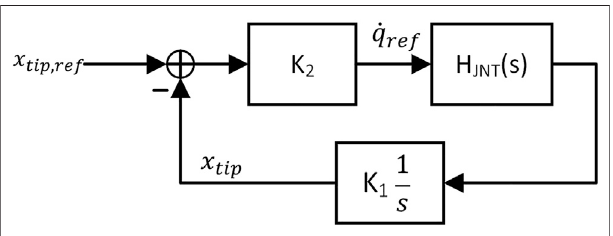
FIGURE 8 | Vision-based servo loop expressed in the context of single joint control with forward kinematics lumped into K 1 and inverse kinematics and tip level position gain lumped into K 2 .